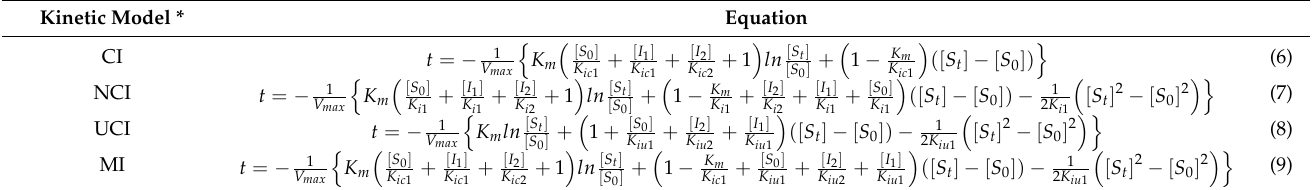
Table 2. Integrated Michaelis–Menten equations obtained from the model explained in Figure 1, considering the simultaneous presence of two mutually exclusive inhibitors when one of which is a reaction product